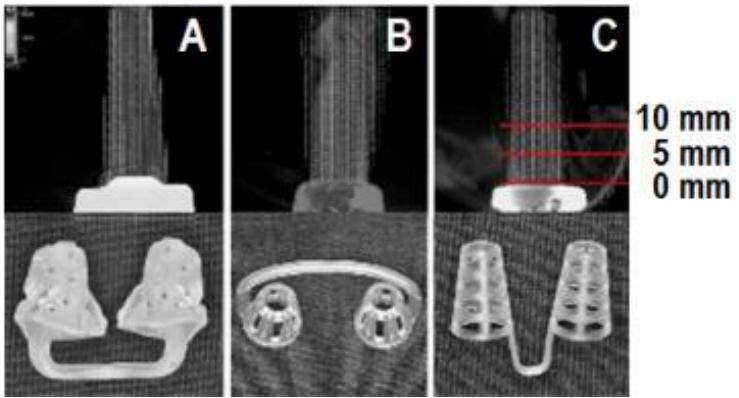
Figure 2. Images of airflow visualization. ( A ) The nasal breathing stent (NBS); ( B ) nose cones; ( C ) mute with hole. Measurements were taken at the appliance exit (0 mm), and at vertical distances of 5 mm and 10 mm from the exit.